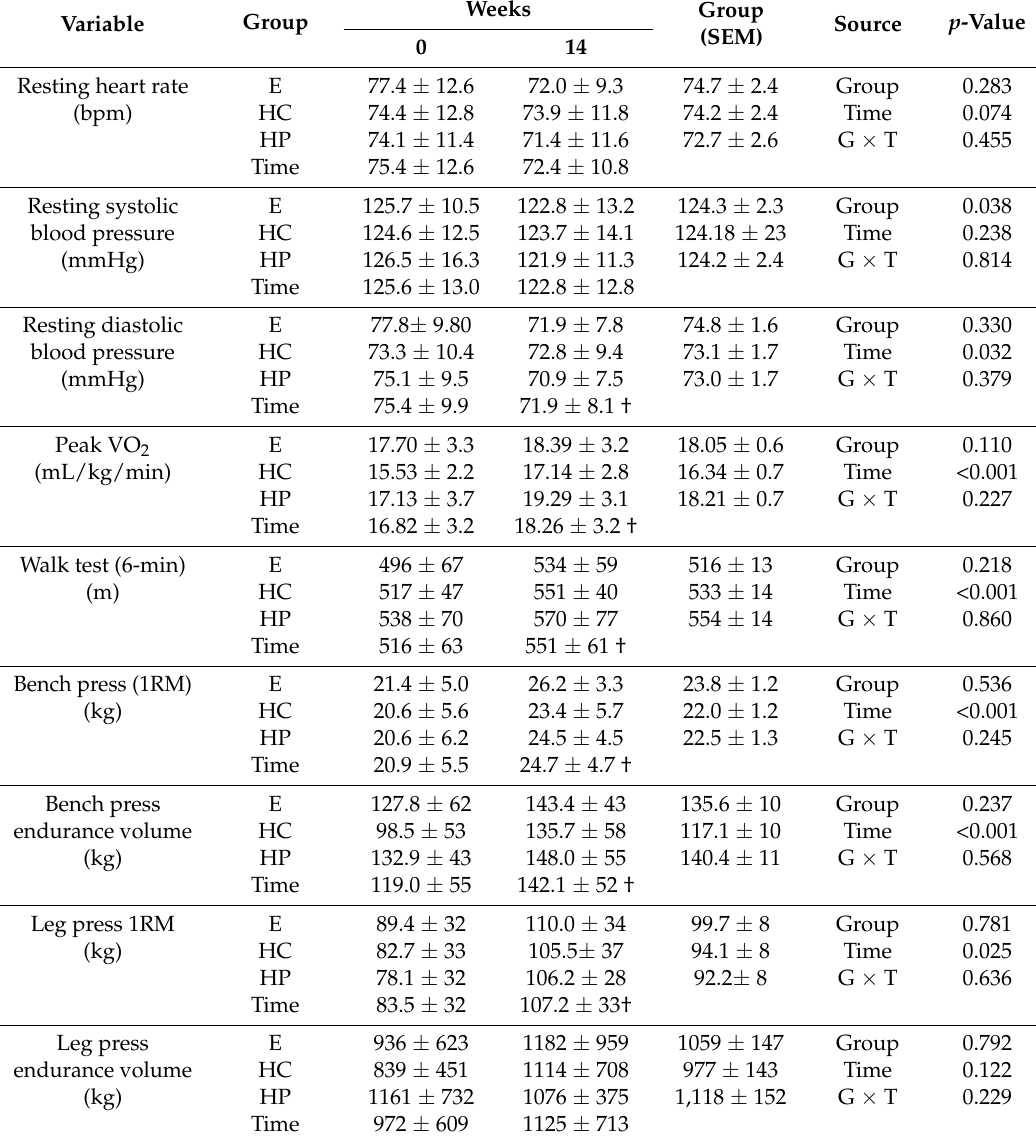
Table 5. Cardiovascular, aerobic capacity, and muscular strength and endurance